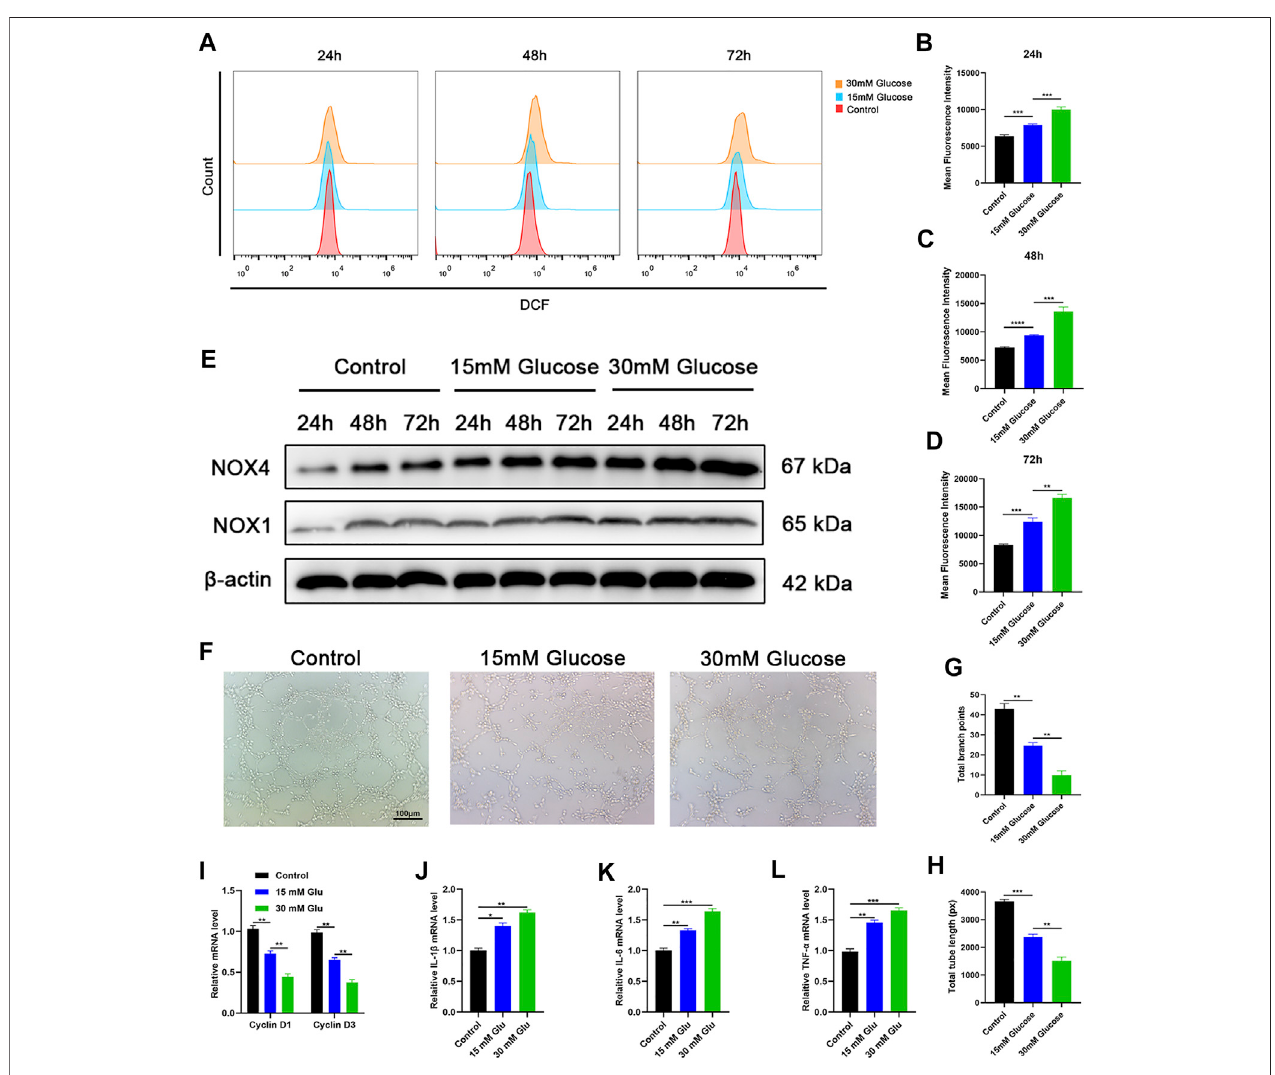
FIGURE 1 | Hyperglycemia drives oxidative stress damage and impairs cellular function in HUVECs. (A) Reduction of reactive oxygen species (ROS) in HUVECs assessed via fl ow cytometry with the DCFH-DA (2 ′ ,7 ′ -dichlorodihydro fl uorescein diacetate) probe following different treatments. (B – D) Quantitation of ROS depletion measuredbytheintensityof fl uorescenceofHUVECs. (E) WesternblottingresultsofNOX1and NOX4inHUVECsfollowingdifferenttreatments atvariedtimepoints. (F) A tube formation assay was performed to visualize the cell capillary network formation of HUVECs. Scale bar: 100 μ m. (G, H) Quantitative analysis of the tube formation of HUVECs in the three groups. (I) RT-qPCR results of cyclin D1 and cyclin D3 expressions in the HUVECs following different treatments; (J – L) RT-qPCR resultsofIL-1 β ,IL-6,andTNF- α expressionsintheHUVECsfollowingdifferenttreatments.Differencesweremeasuredbyone-wayANOVAfollowedbyaTukey posthoc test for pairwise comparison. Data presented as means ± SD. **** p < 0.0001, *** p < 0.001, ** p < 0.01, and * p < 0.05.